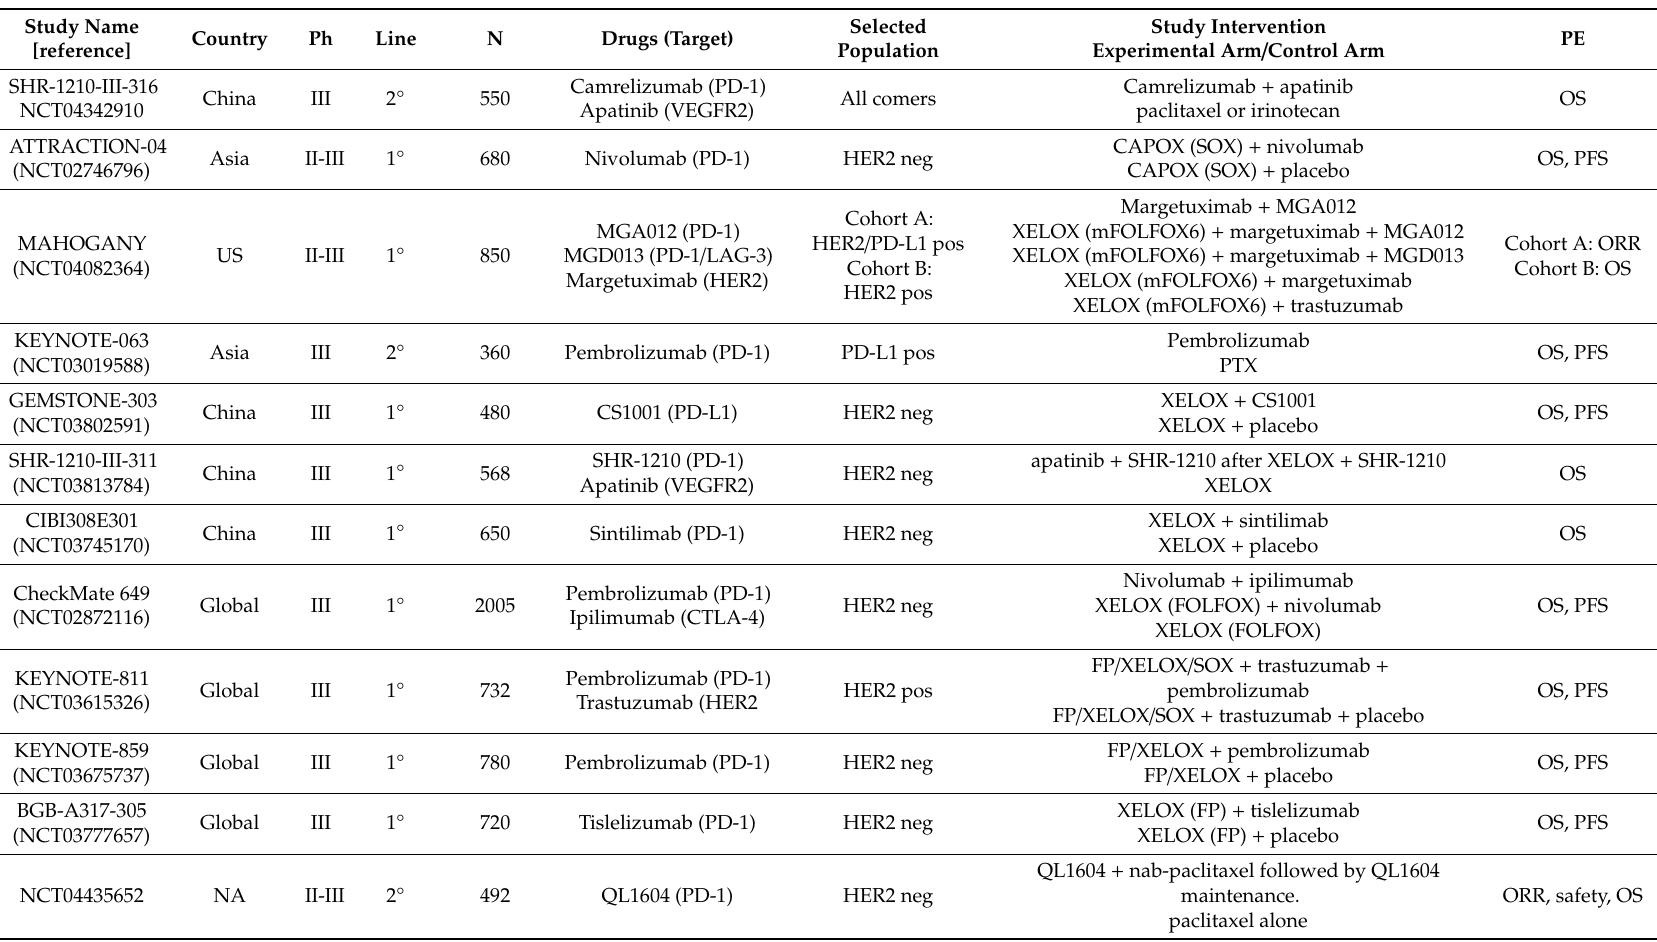
Table 2. List of ongoing phase III or II / III trials with immune checkpoint inhibitors in metastatic gastric